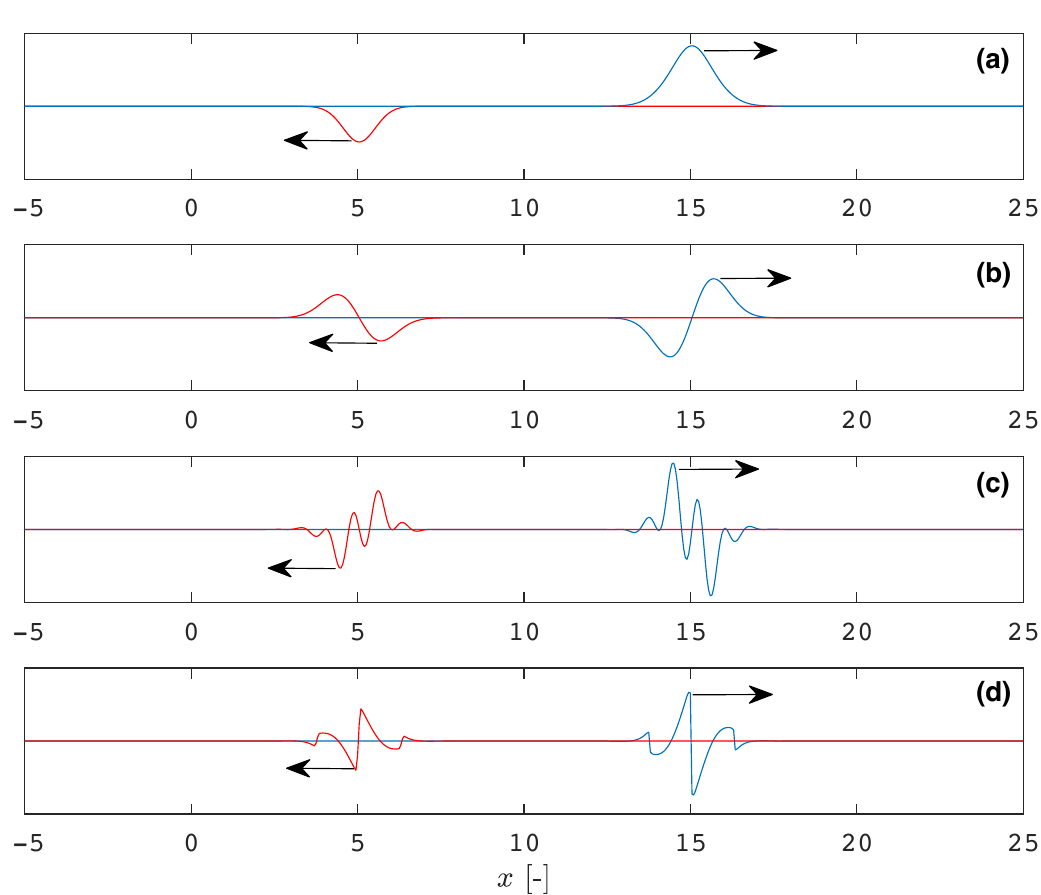
Figure 2. Comparison between the original disturbance (blue) and the time reversed wave packet (red) for different initial envelopes: ( a ) e − X 2 ; ( b ) e − X 2 sin X ; ( c ) e − X 2 sin3 X cos5 X ; (cid:16) (cid:17) + 5 X (cid:99) ( d ) 2e − X 2 5 X − (cid:98) 1 ; all with n = 0, κ = 2